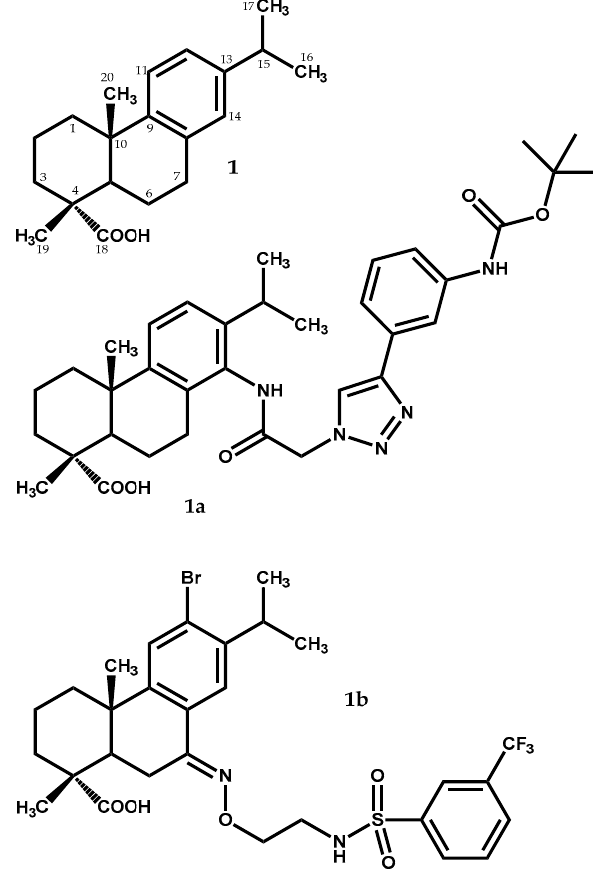
Figure 1. Dehydroabietic acid ( 1 ) identified in Juniperus species and its derivatives ( 1a and 1b ) with significant cytotoxic and antibacterial activities.